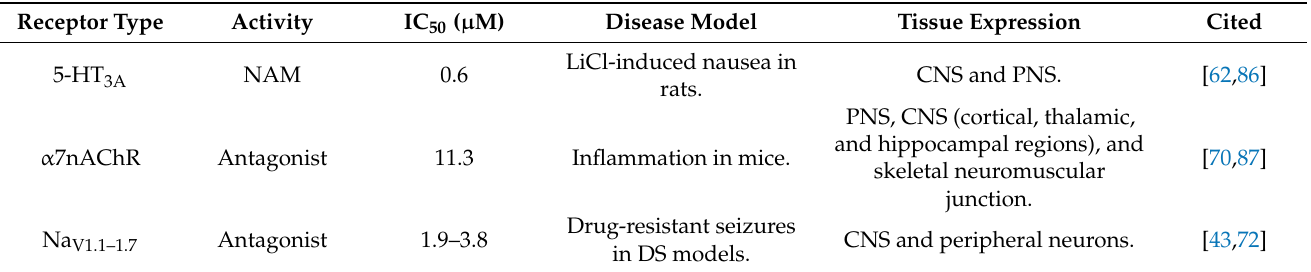
Table 3. CBD such as an antagonist, NAM, or inverse agonist of receptors in the nervous system. Receptor